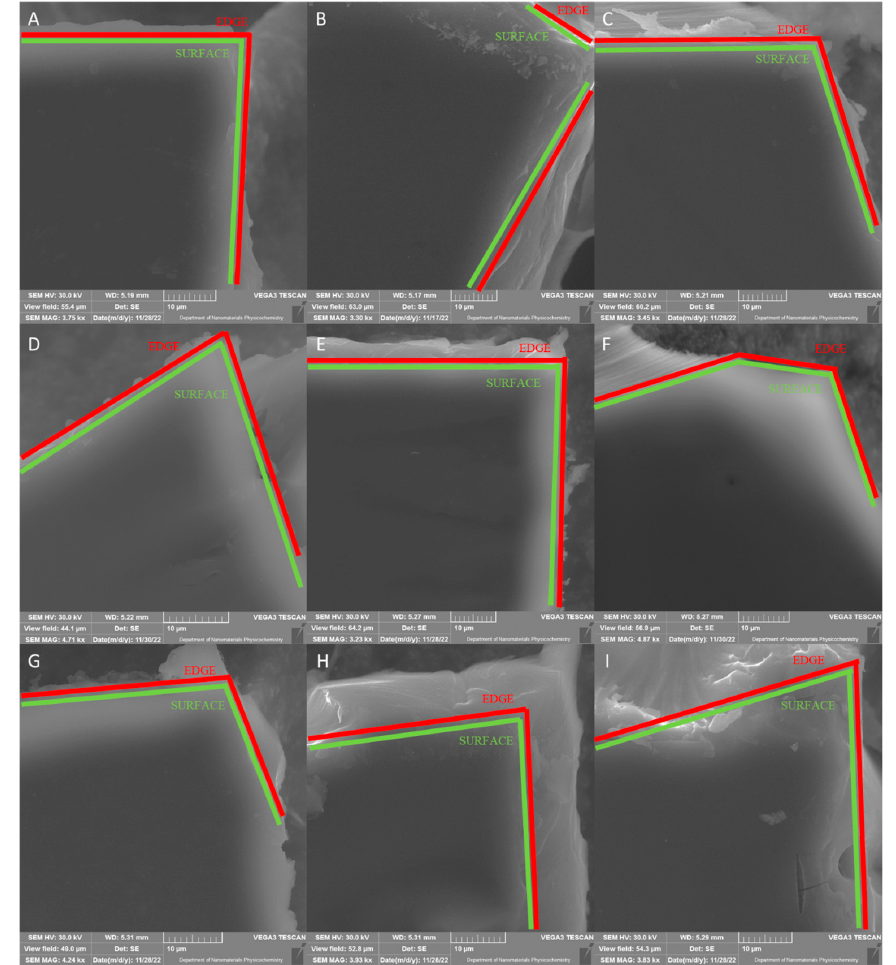
Figure 4. SEM images of CMC 0.7 ( A ), CMC 0.9 ( B ), CMC 1.2 ( C ), CMC 0.7 + MEL ( D ), CMC 0.9 + MEL ( E ), CMC 1.2 + MEL ( F ), CMC 0.7 + Ag ( G ), CMC 0.9 + Ag ( H ), CMC 1.2 + Ag ( I ) of obtained samples.